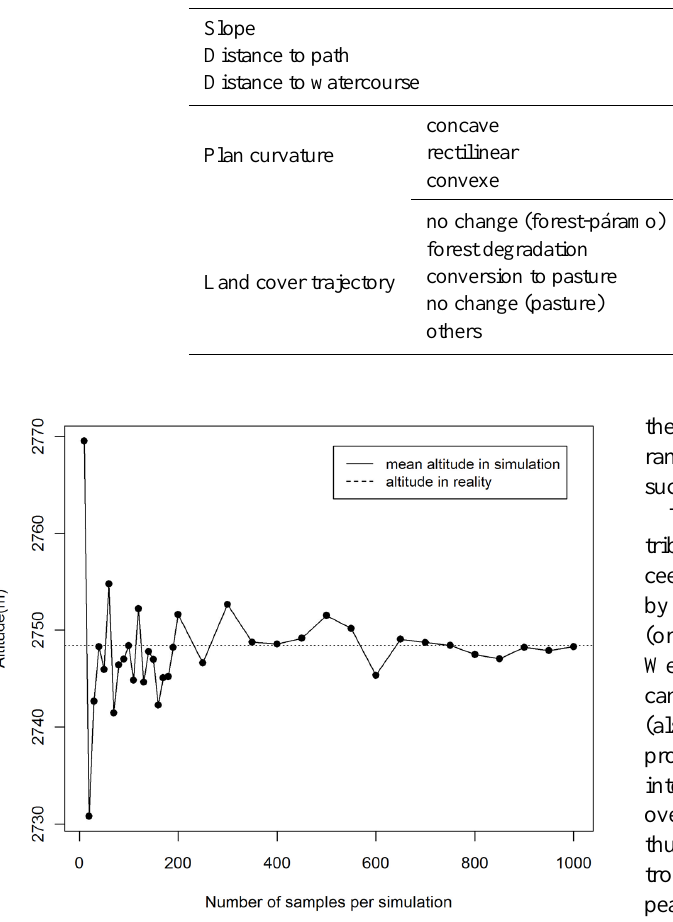
Fig. 3. According to the Monte Carlo principle, a sufficient number of randomly selected samples are needed to approximate correctly the true population (Llavircay catchment in this case). A simulation with 1000 samples provides a stable empirical